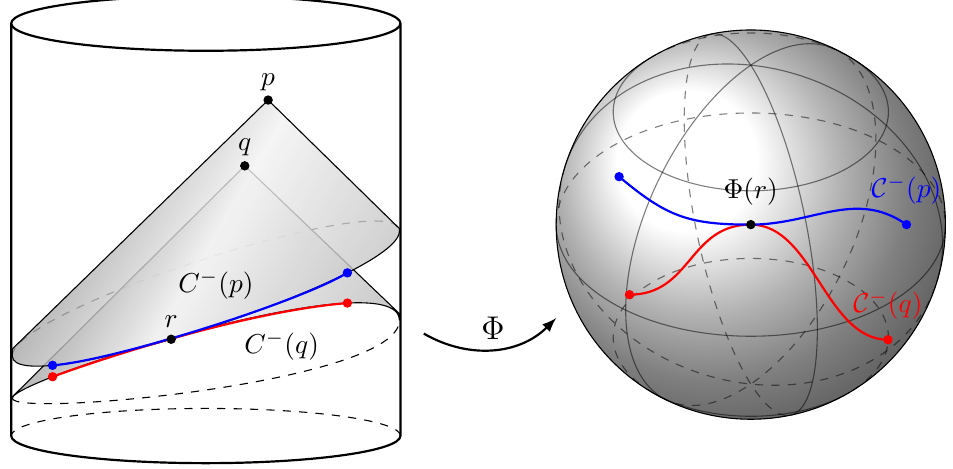
Figure 5 . By theorem 1, two extended cuts ( r; (cid:8)( r )) only if they correspond to distinct, null-related points p; q requires both that their standard cuts C ( p ) and C ( q ) intersect at precisely one point r also that their images under the map (cid:8) intersect precisely at (cid:8)( r )